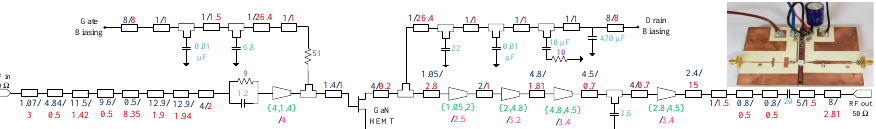
Figure 5. Fabricated EM-based HPA, designed by proposed DNN-based optimization method. Units of each capacitor and resistor are pF and Ohm, respectively; “/” represents width/length in mm unit (cid:110) (cid:111) and “ ” represents Width 1 , Width 2 of tapered lines in mm unit. ,